Question: Provide a one-line summary of what is displayed.
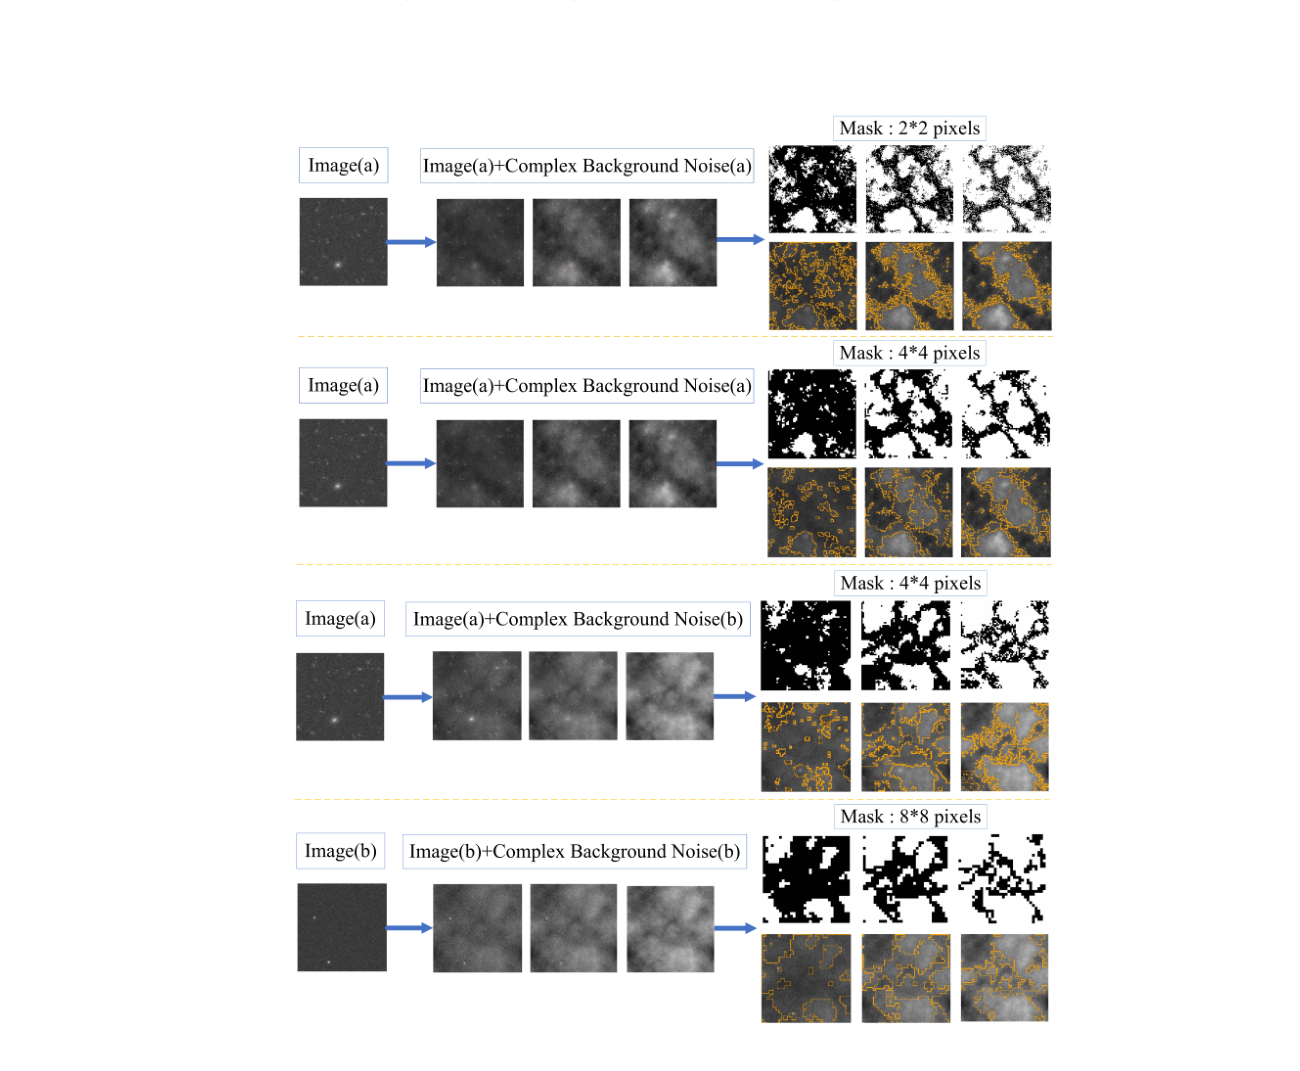
Answer: The figure shows simulated images with different levels of complex background noise. The second and third parts show the results of the same original simulated image using different levels of complex background noise. The first column image represents the original simulated image, while the second to fourth columns images represent images with different complex background noise. Images of columns 5th to 7th are results obtained by our method with different mask sizes and combinations of original image and the contour of ground-truth complex background noise distribution.